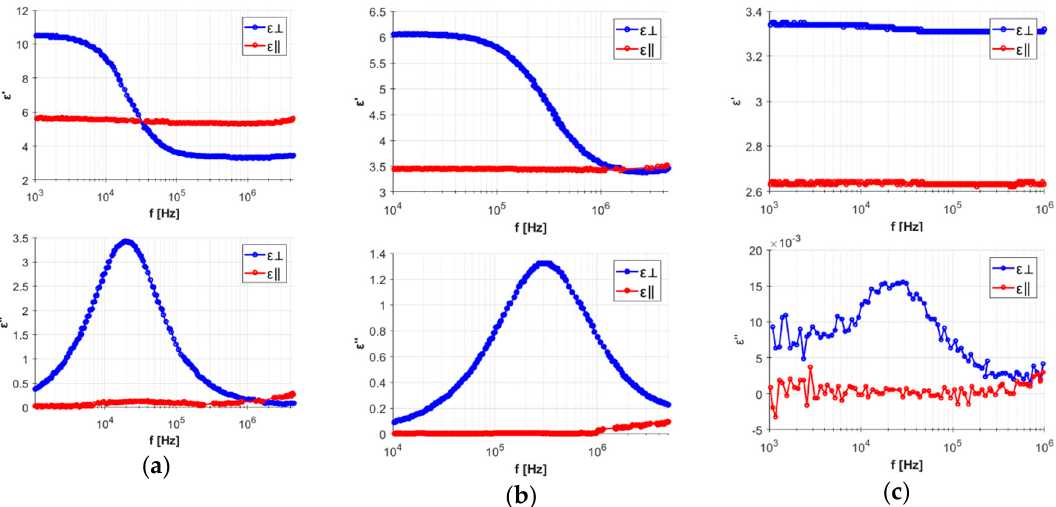
Figure 2. Frequency dependence of the real part (upper) and imaginary part (lower) of the complex permittivity of the formulated mixture in the measuring frequency range 100Hz to 1MHz for the three different components of the mixture: ( a ) component (I), ( b ) component (II) and ( c ) component (III). Table 2. Mesomorphic properties of the three components of the mixture under